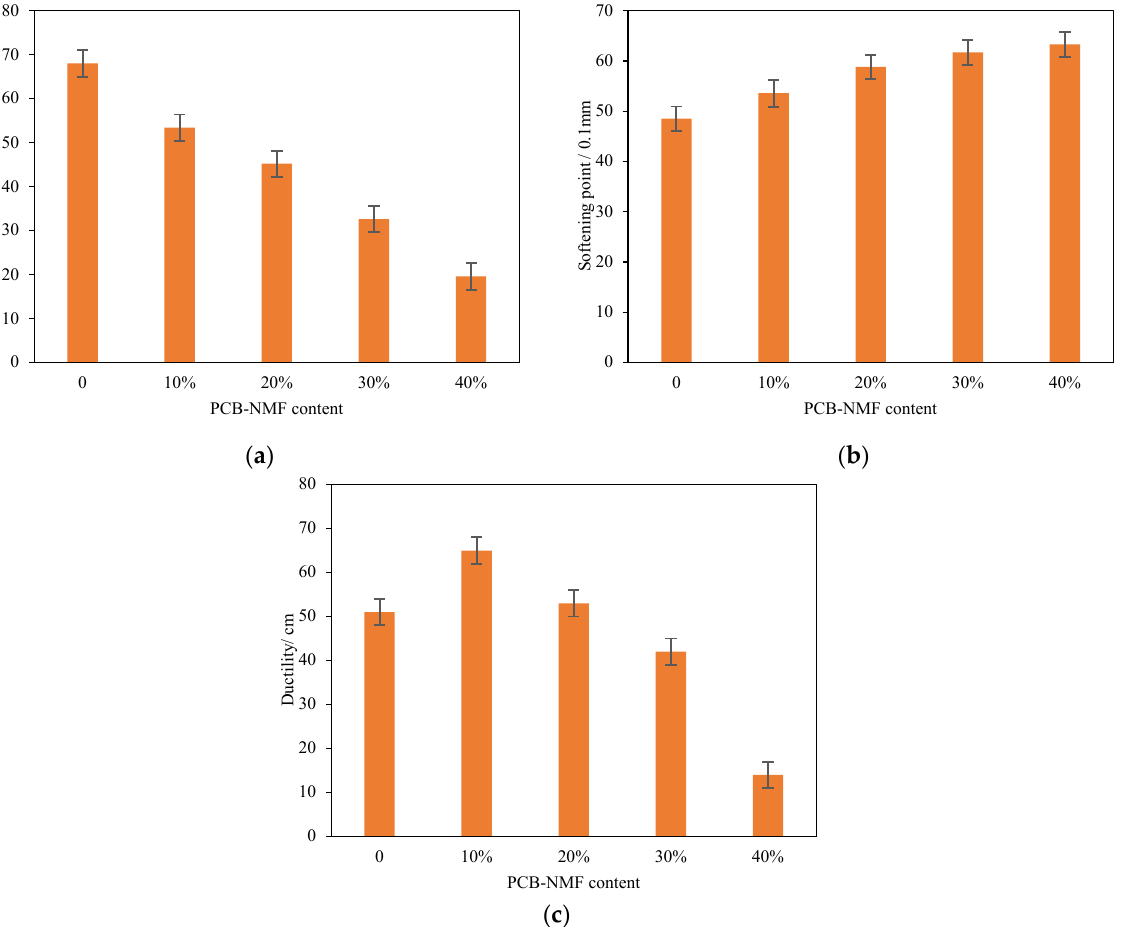
Figure 5. 0%, 10%, 20% 30%, and 40% of PCB-modified asphalt tested for: ( a ) penetration, ( b ) softening point, and ( c ) ductility.